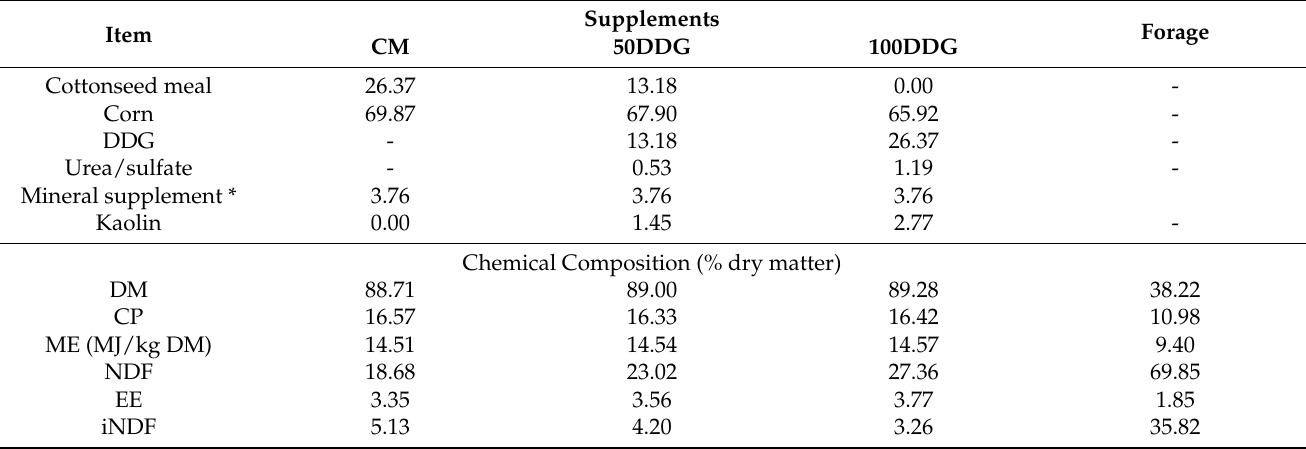
Table 3. Percentage of inclusion and chemical composition of supplements and forage in the pasture finishing